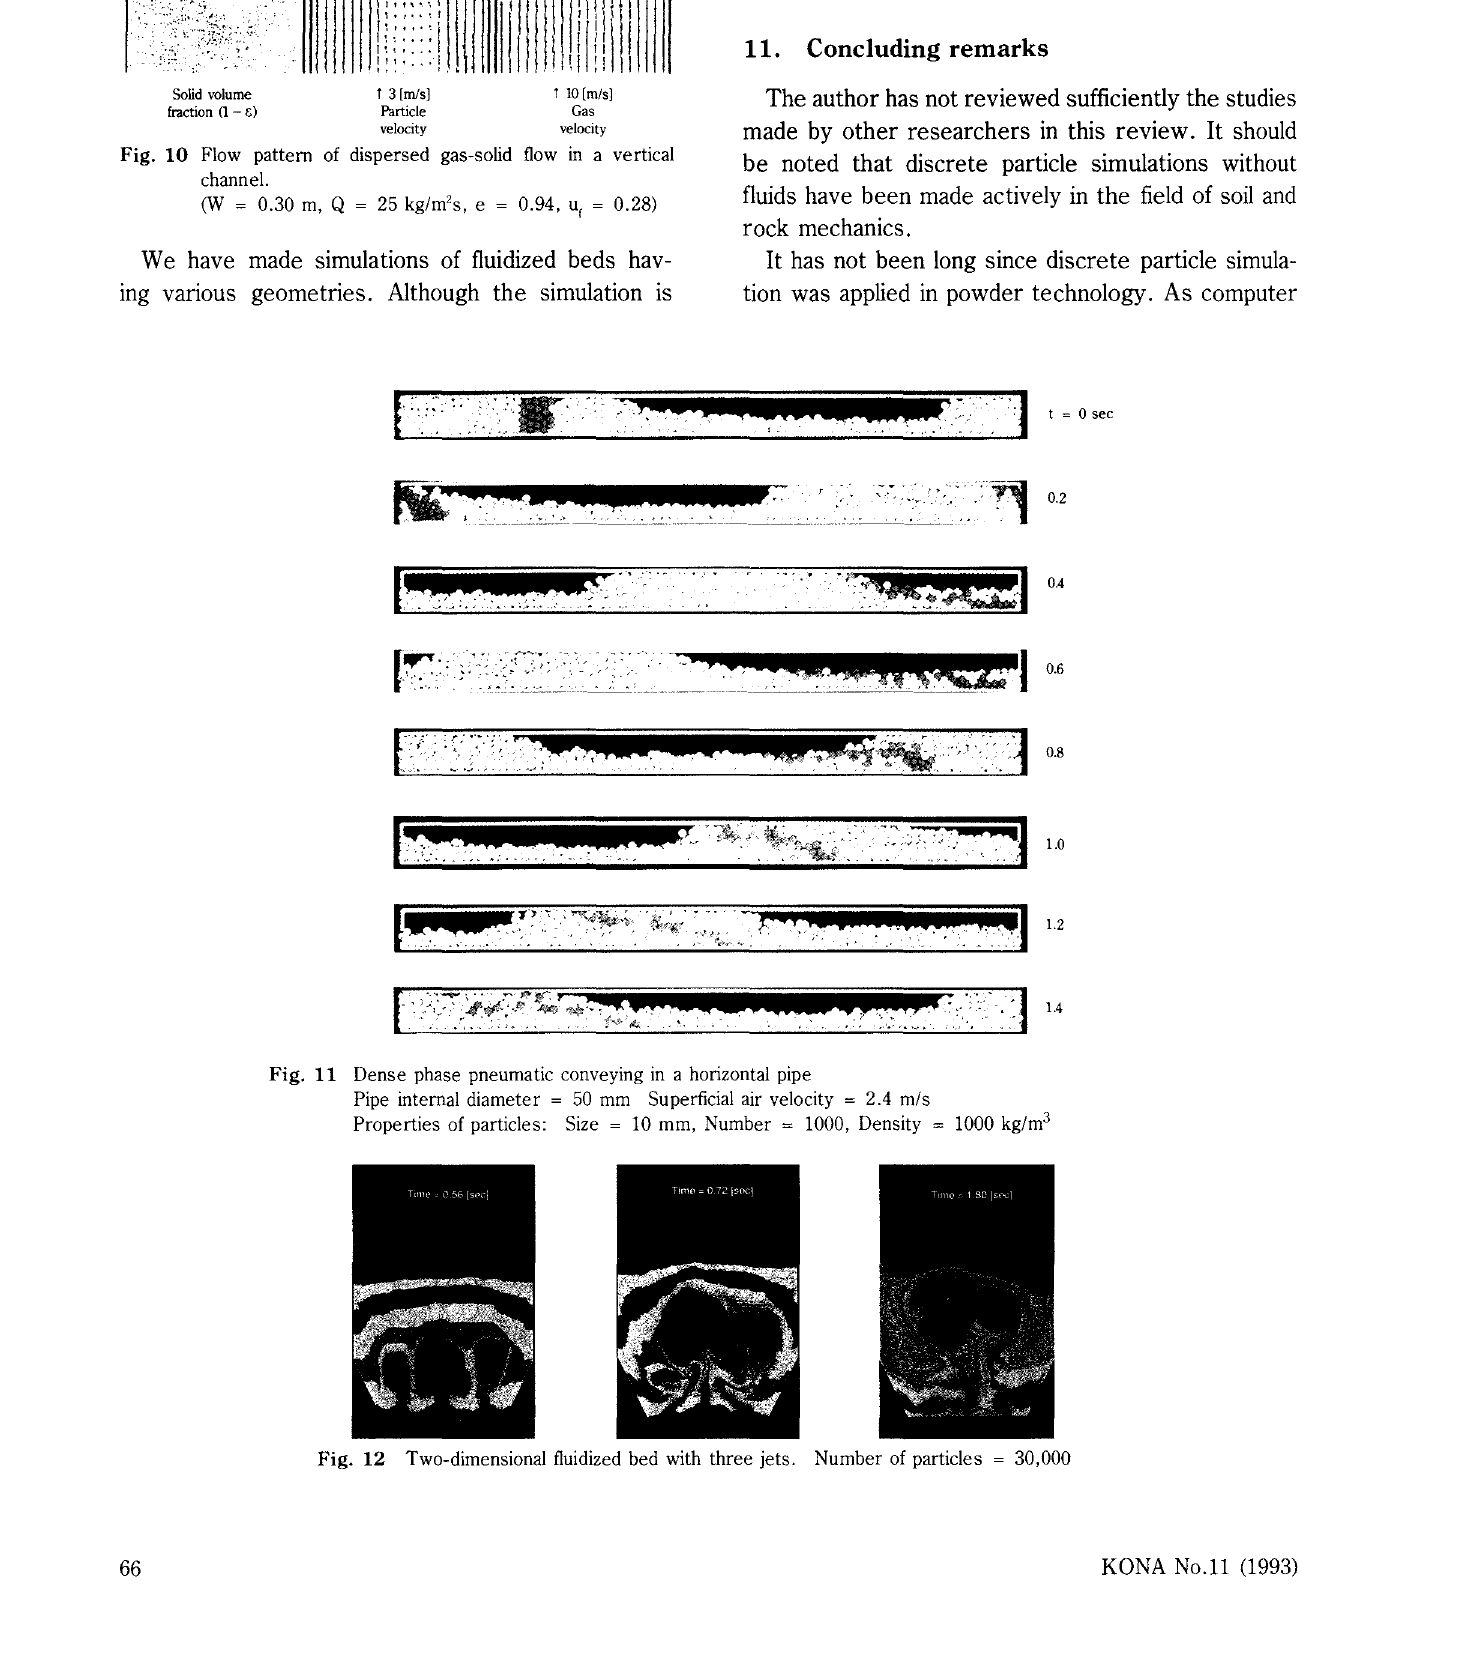
Fig. 10 Flow pattern of dispersed gas-solid flow in a vertical channel.